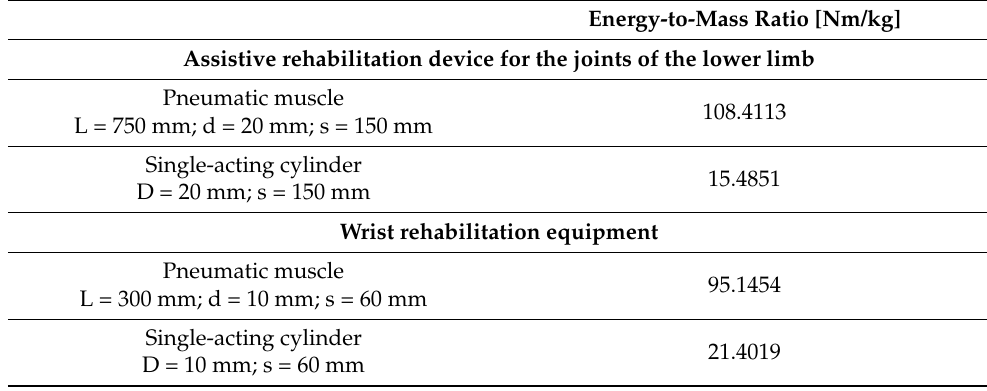
Table 8. Comparison of the energy-to-mass ratios computed for the two types of actuators.